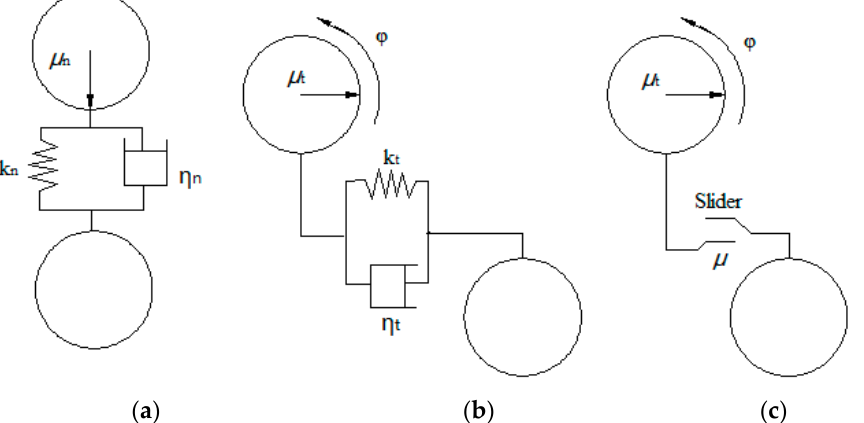
Figure 1. Principle of the simulation model. ( a ) normal vibration; ( b ) tangential vibration; ( c ) tangential sliding.